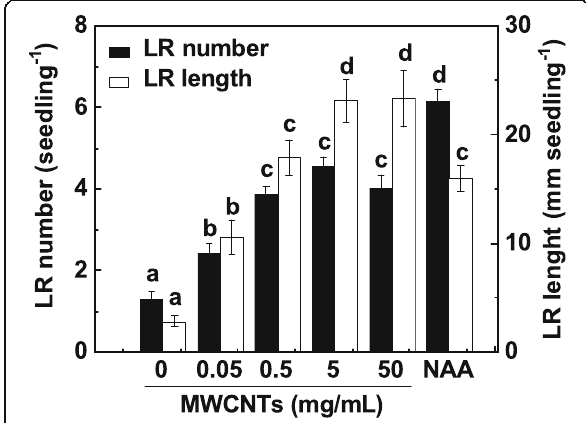
Fig. 1 MWCNT-induced tomato LR formation was in an approximately dose-dependent manner. Three-day-old tomato seedlings were treated with 200 nM NAA and the indicated concentrations of MWCNTs, respectively. The number and length of emerged lateral root (> 1 mm) per seedling were then determined after 3 days of treatment. There were 30 (10 × 3) plants in three biological replicates, and the experiments were conducted for 3 times. Data are the means± SE. Within each set of experiments, bars denoted by the same letter did not differ significantly at p < 0.05 level according to Duncan ’ s multiple